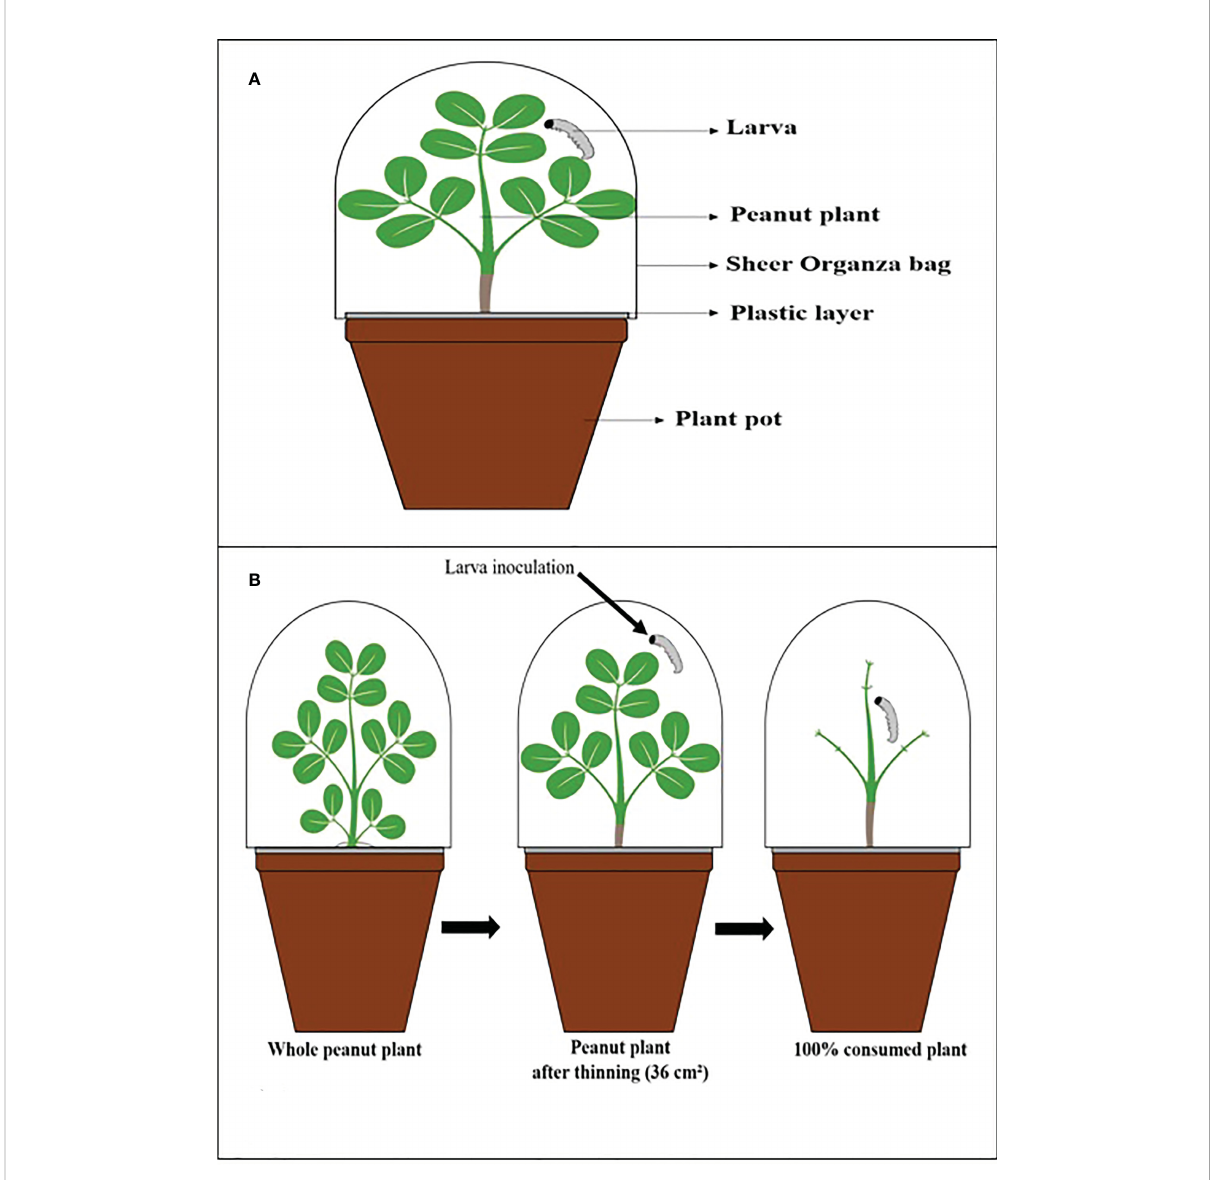
FIGURE 1 Illustrative scheme. (A) The vessel used in the experiments. (B) Thinning process of peanut plants, inoculation, and after being consumed by the